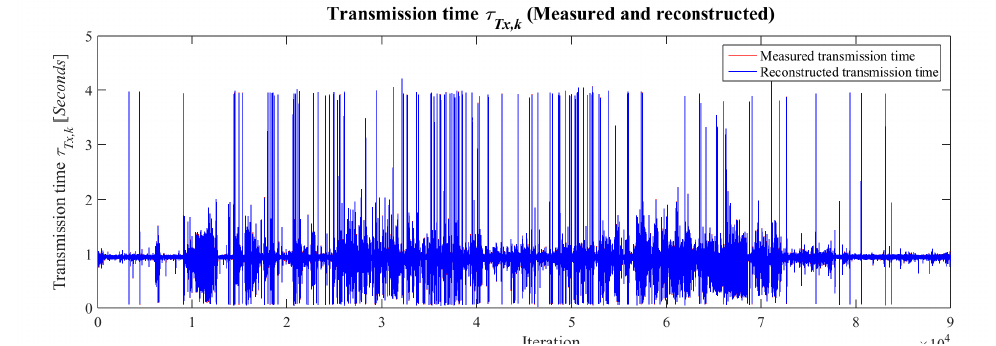
Figure 15. Comparison of transmission times τ Rx , k measured and reconstructed.